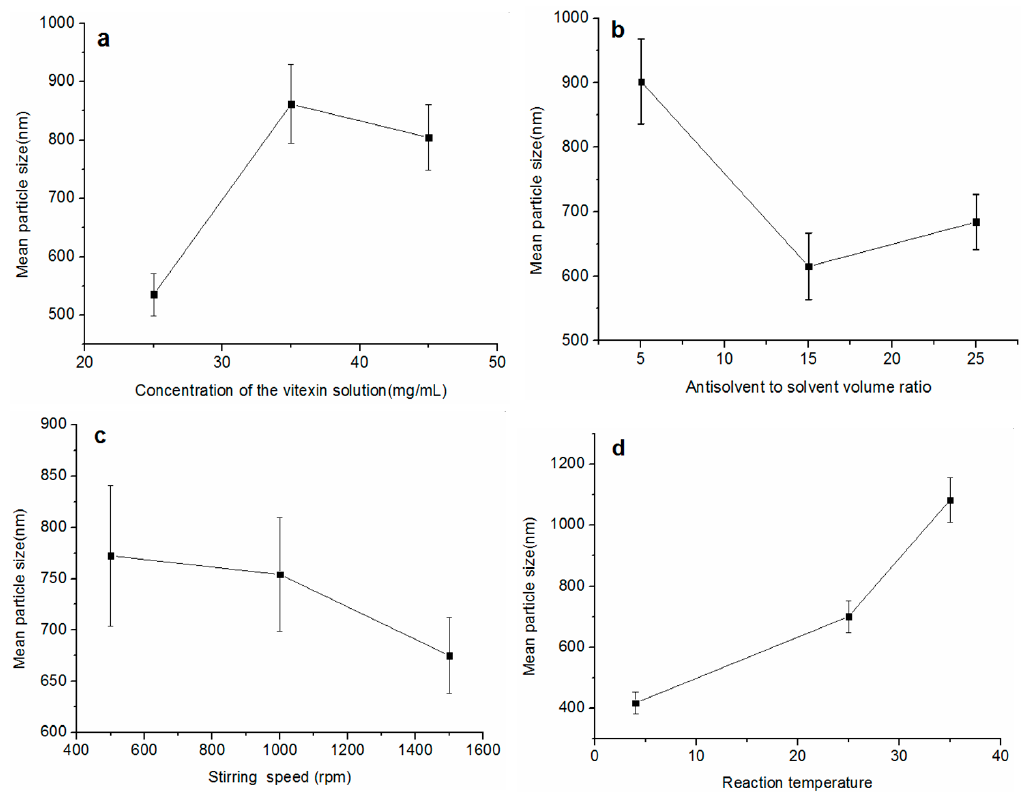
Figure 2. The effect of each factor on the MPS of vitexin particles. ( a ) concentration of the vitexin solution; ( b ) antisolvent to solvent volume ratio; ( c ) stirring speed; ( d ) reaction temperature.